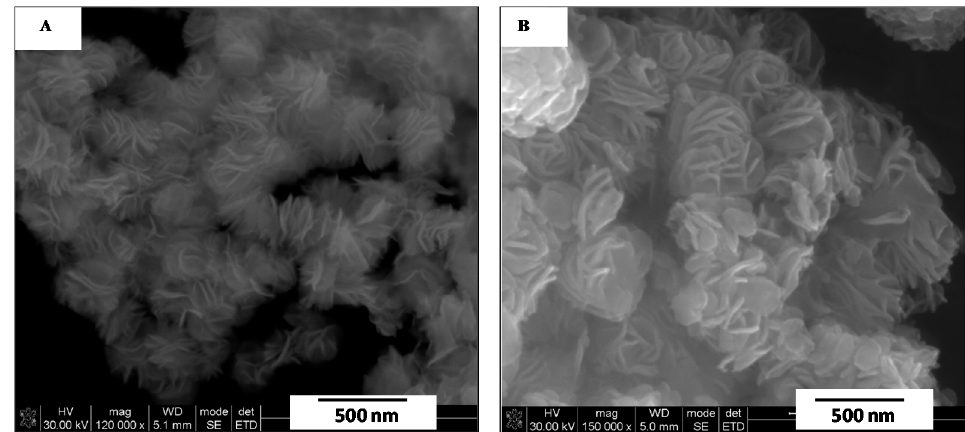
Figure 6. ( A , B ) SEM characterization of WS 2 nanoflowers.